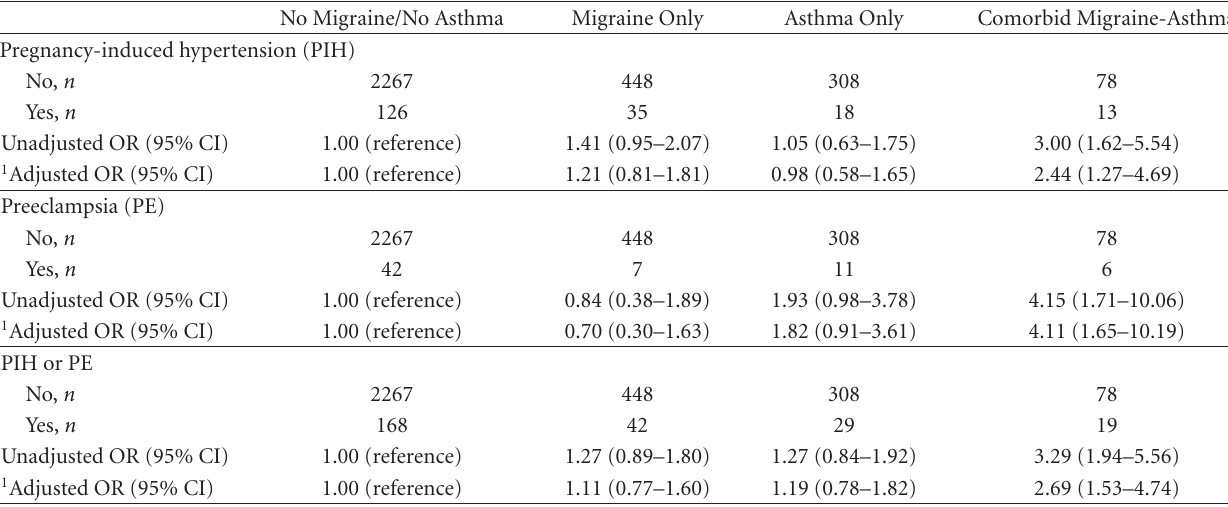
Table 4: Unadjusted and adjusted odds ratios (ORs) and 95% confidence intervals (CIs) of hypertensive disorders of pregnancy in relation to maternal migraine and asthma status, Seattle and Tacoma, WA, USA, 1996–2008. No Migraine/No